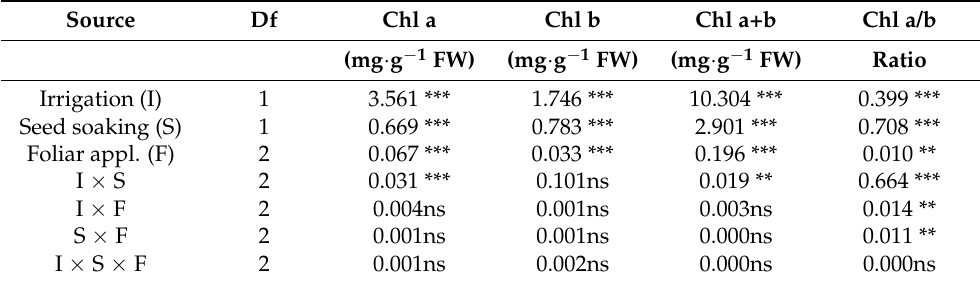
Table 2. Analysis of variance (mean square) of leaf chlorophyll